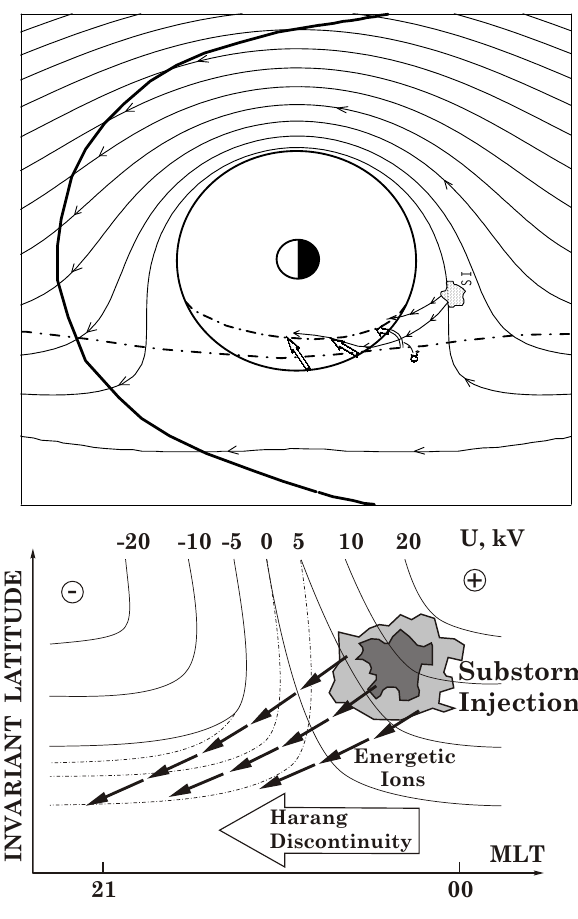
Fig. 1. Schematics of particle injection location, distortion of the Volland-Stern convection pattern at subauroral latitudes, and trajec- tories of injected energetic ions forming the Polarization Jet (not to scale). Thin lines - equipotentials before the injection, dot-dashed lines - after the injection. Hollow arrows show the inward and west- ward shift of the equipotential line in the evening sector, lines with arrows - trajectories of the drifting ions penetrating to lower L - shells (not to scale). (a) At the equatorial plane; (b) At ionospheric